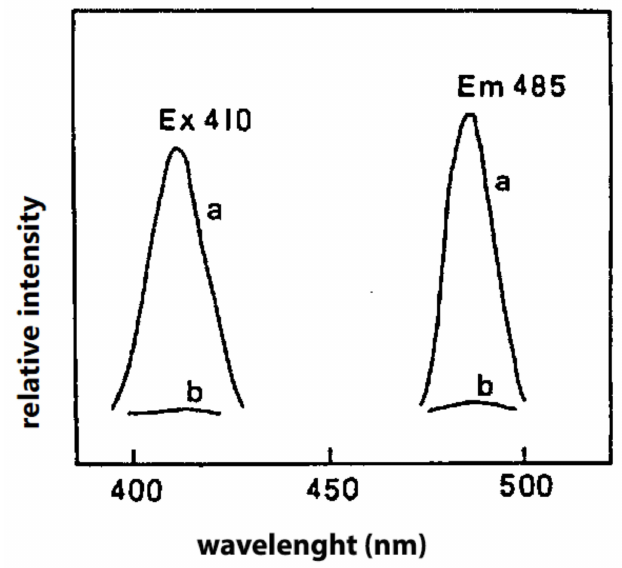
Figure 8. Fluorescence spectra of the hydroxylation product of l-methyl indole in pea peroxygenase reaction with methyl linoleate hydroperoxide (500 nmol); ( a ) in the presence and ( b ) in the absence of the enzyme. Adopted with permission from [49]. Copyright 1993, John Wiley &